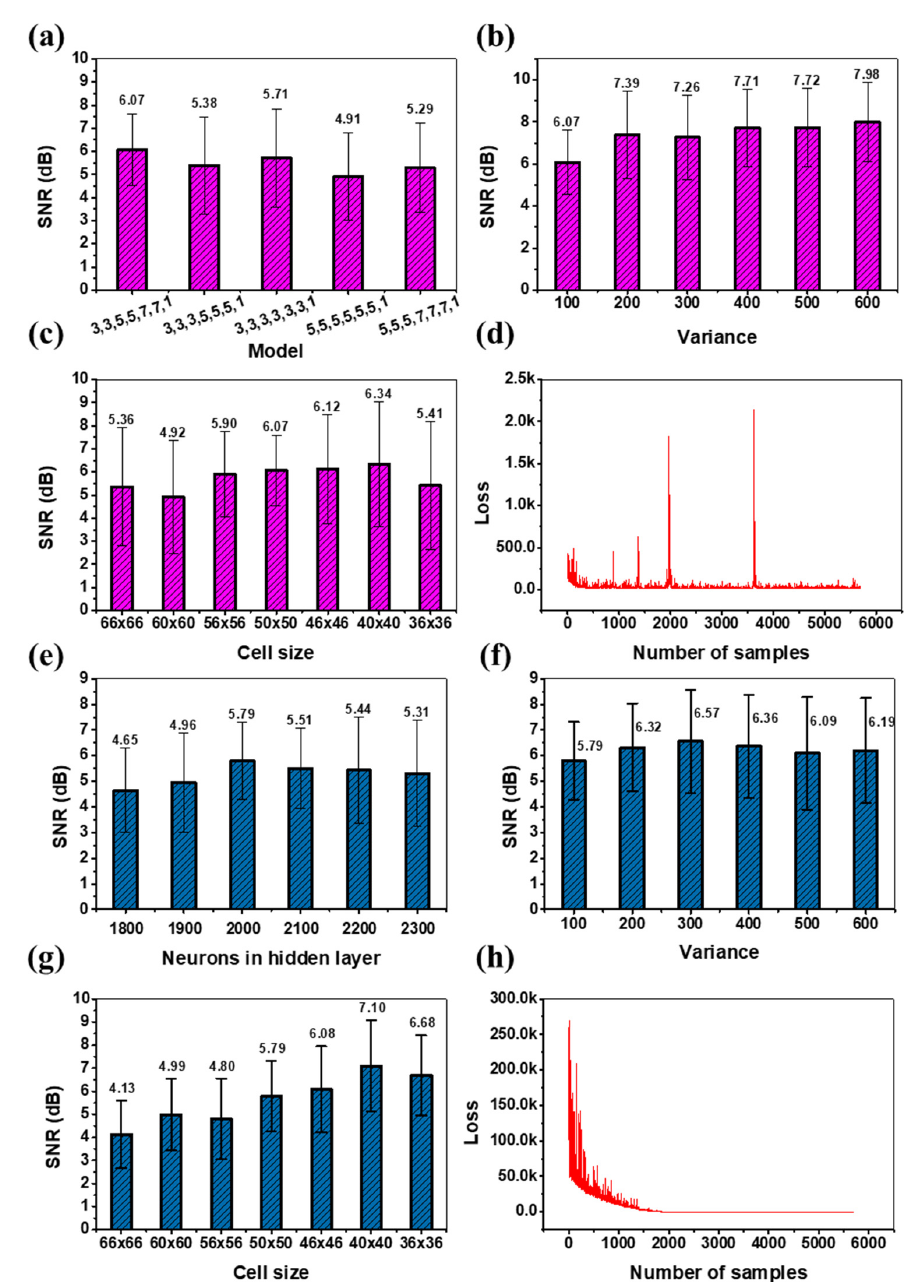
Figure 3. Results from the CNN and ELM autoencoder. ( a ) The performance of the CNN autoencoder for improved SNR (average of all of the classes) across various layers and kernel sizes. ( b ) The performance of the CNN autoencoder across varying noise levels. Here, the variance of the Gaussian noise ranges from 100 to 600, and is evaluated on the optimal network architecture, i.e., 3,3,5,5,7,7,1. ( c ) The performance of the CNN autoencoder across various input sizes (cropping size). Here, the sizes vary from 66 × 66 to 36 × 36. ( d ) The convergence of the optimal CNN network with the number of samples for the first epoch. ( e ) The number of hidden layer neurons in ELM autoencoder vs. improvement in SNR , ( f ) variance vs. improved SNR for ELM autoencoder, ( g ) Input size vs. improved SNR for ELM autoencoder, and ( h ) The convergence of ELM autoencoder within the first epoch.